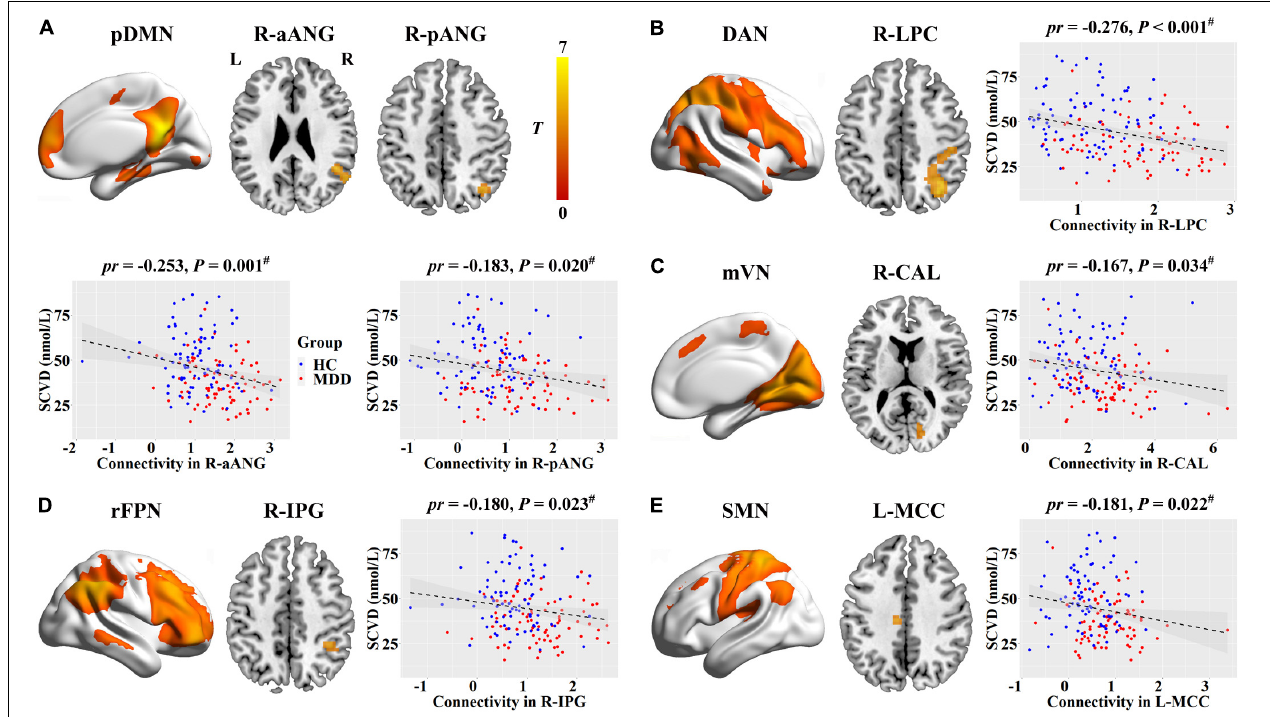
FIGURE 3 | Associations between SCVD and intranetwork functional connectivity in females. (A–E) SCVD was correlated with intranetwork connectivity in brain regions showing group differences; scatter plots show the correlations between SCVD and intranetwork connectivity. The warm color denotes increased intranetwork connectivity in MDD patients. # P < 0.05, false discovery rate correction for multiple comparisons. SCVD, serum concentration of vitamin D; pDMN, posterior default mode network; aANG, anterior angular gyrus; pANG, posterior angular gyrus; DAN, dorsal attention network; LPC, lateral parietal cortex; mVN, medial visual network; CAL, calcarine sulcus; rFPN, right frontoparietal network; IPG, inferior parietal gyrus; SMN, sensorimotor network; MCC, middle cingulate cortex; HC, healthy controls; MDD, major depressive disorder; L, left; R,